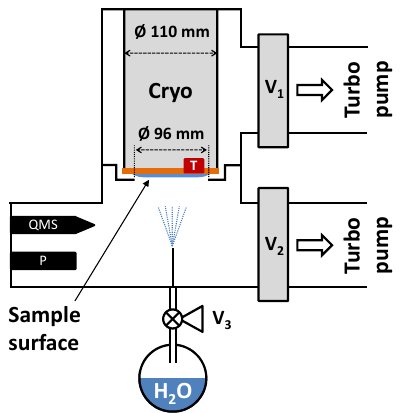
Figure B1. Experimental setup used for the relative saturation va- por pressure measurements between 166 and 190K. A hot-cathode ionization gauge ( P ) is employed in a vacuum chamber, which is evacuated via valves V 1 and V 2 by two turbo molecular pumps. Simultaneous quadrupole mass spectrometer (QMS) measurements ensure that no trace gases other than H 2 O bias the pressure readout. See text for details.